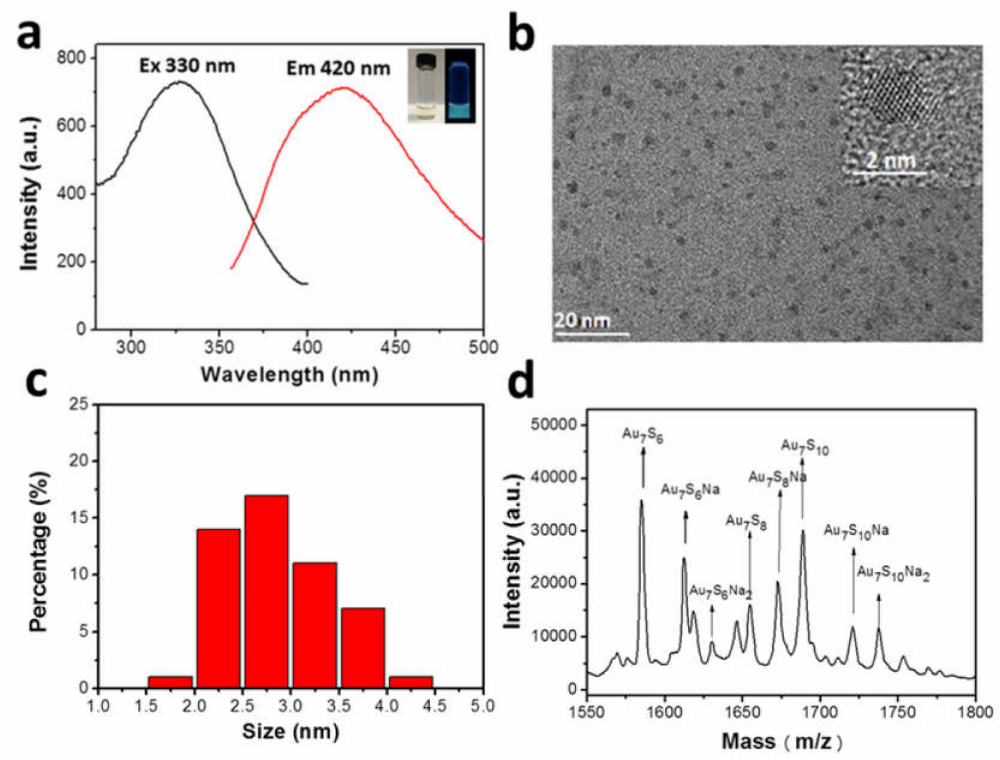
Figure 1. ( a ) Fluorescence excitation/emission spectra of AuCs. Insets present images of AuCs under visible (left) and 365 nm portable UV light (right) radiation; ( b ) HRTEM images of the nanoparticles derived from the clusters under the electron radiation. Size distribution ( c ) and MALDI-TOF MS analysis ( d ) of peptide-modified